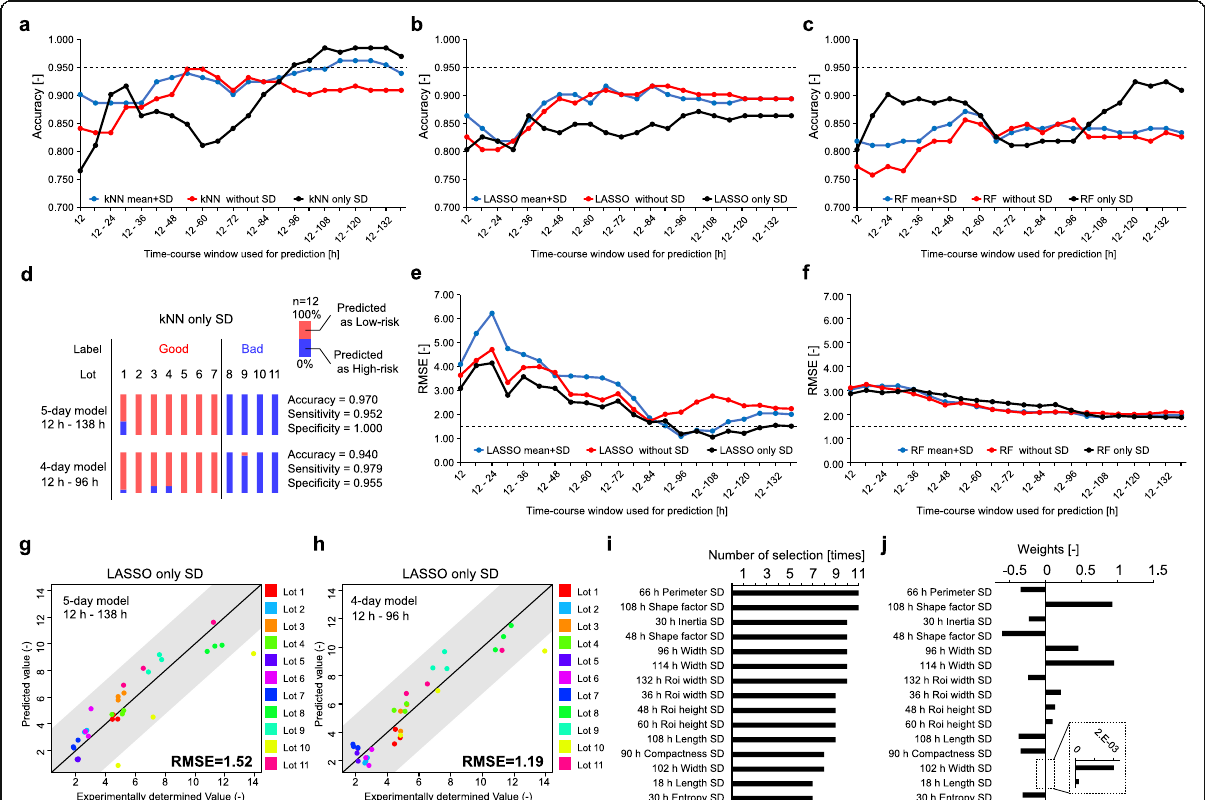
Fig. 4 Morphology-based prediction of MSC ’ s potencies. a – c Classification performance of T-cell proliferation inhibitory potency compared with modeling methods, type of using morphological parameters, and usage of time-course window size. Samples was classified into two categories: (Low-risk lots) Lots 1 – 7, (High-risk lots) Lots 8 – 11. kNN ( a ), LASSO ( b ), and RF ( c ) were compared. Mean + SD: using total 32 morphological parameters combining both mean- and SD-related parameters, Without SD: using mean-related 16 parameters, Only SD: using SD-related 16 parameters. The best model that exceeded the dotted line performance was selected. d Comparison of 5-day and 4-day models with each lot prediction results. e , f Prediction performance of growth rate compared with modeling methods, type of using morphological parameters, and usage of time-course window size. The growth rate (cells in the image at 138 h/cell in the image at 12 h) was used for training each sample. LASSO ( e ) and RF ( f ) were compared. Mean + SD: using a total of 32 morphological parameters combining both mean- and SD-related parameters, Without SD: using mean-related 16 parameters, Only SD: using SD-related 16 parameters. The best model showing RMSE lower than the dotted line performance was selected. g 5-day model performance of growth prediction. h 4-day model performance of growth prediction. i Top 15 parameters selected in the LASSO with only SD model. The number of selections indicates the total number of selections during the leave-lot-out cross-validation. j Weights for the top 15 parameters selected in the LASSO with the only SD